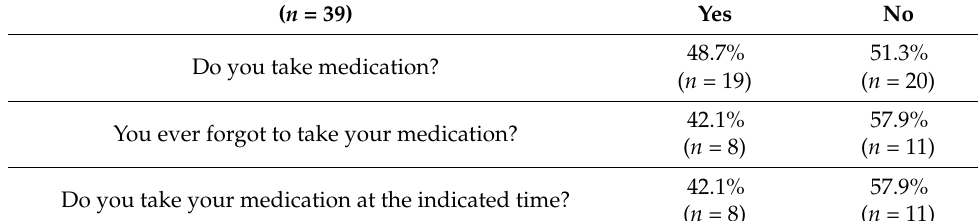
Table 2. Data on adherence to medication in the last month before the psychosocial intervention. ( n = 39) Yes No Do you take medication? You ever forgot to take your medication?